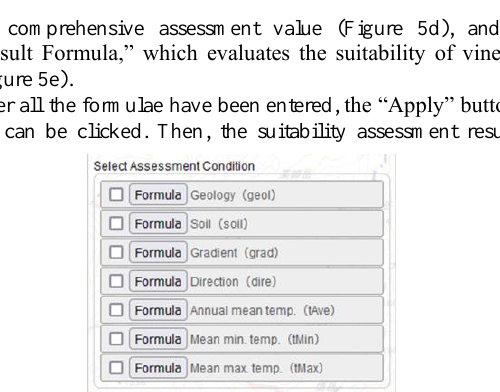
Figure 4. Panel for the assessment formula input